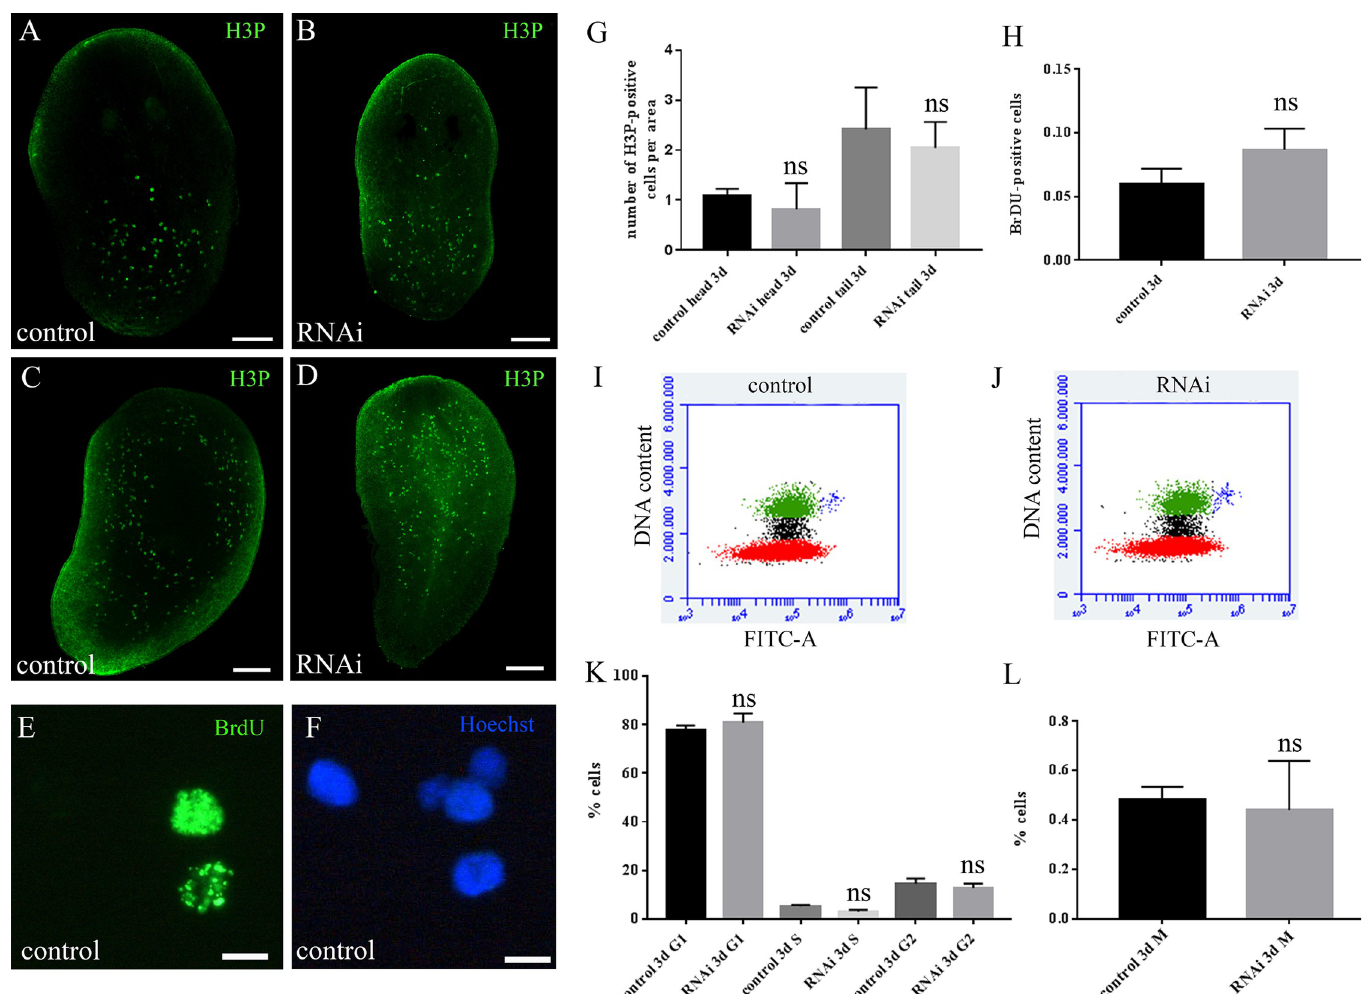
Fig 3. Analysis of proliferating cells in DjMap1B -silenced animals. (A) Representative confocal image of H3P-positive cells (green dots) in a control regenerating head fragment and (B) in a DjMap1B silenced regenerating head fragment (RNAi) 3 days after amputation. (C) Representative confocal image of H3P-positive cells (green dots) in a control regenerating tail fragment and (D) DjMap1B silenced regenerating tail fragment (RNAi) 3 days after amputation. (E) Representative image depicting BrdU- positive cells 3 days after amputation and 1 day after BrdU injection. (F). The same cells in E were stained with Hoechst 33352 blue nuclear staining. (G) Graph depicting the quantification of H3P-expressing cells in control and RNAi regenerating fragments 3 days after amputation. Each bar is the mean ± standard deviation of 5 independent samples of a representative experiment, ns: not significant (p > 0.05). (H) Graph illustrating the quantification of BrdU-expressing cells 3 days after amputation and 1 day after BrdU injection. Each bar is the mean ± standard deviation of 5 independent samples of a representative experiment, ns: not significant (p > 0.05). (I) Representative plot depicting the distribution in the cell cycle of cells obtained from control animals and (J) DjMap1B -silenced animals (RNAi) 3 days after amputation. Red: G1-phase cells; black: S-phase cells; green: G2-phase cells; blue: M-phase cells. (K-L) Graph depicting the percentage of cells in the different phases of the cell cycle. Each bar is the mean ± standard deviation of 5 independent samples of a representative experiment. ns: not significant (p > 0.05). d (days); h (hours). Scale bar is 500 μ m in A-D and 10 μ m in